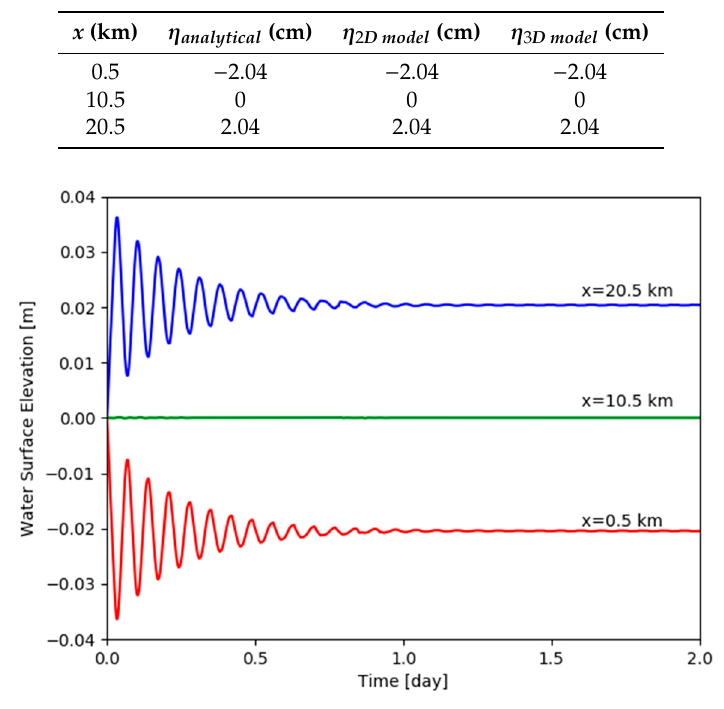
Figure 7. Numerical results of the wind setup test (2D simulation results).